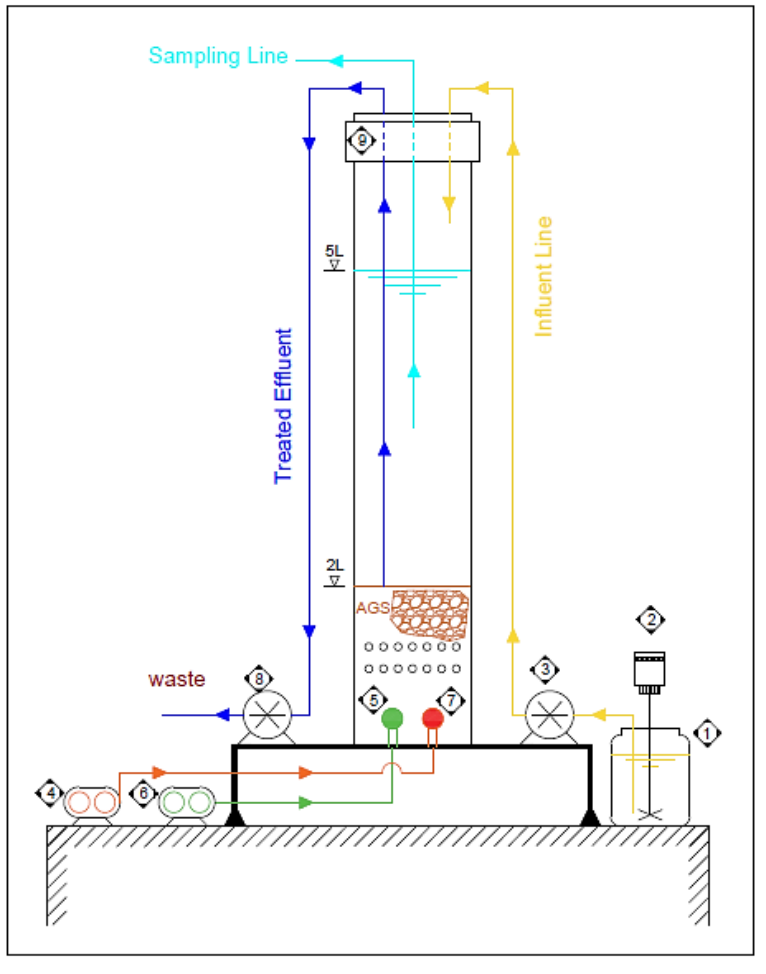
Figure 1. Schematic of the GSBRs in this study; (1) feeding tank; (2) mixer; (3) feeding pump; (4) nitrogen pump; (5) nitrogen diffuser; (6) air pump; (7) air diffuser; (8) decant pump; and (9) reactor’s cap.